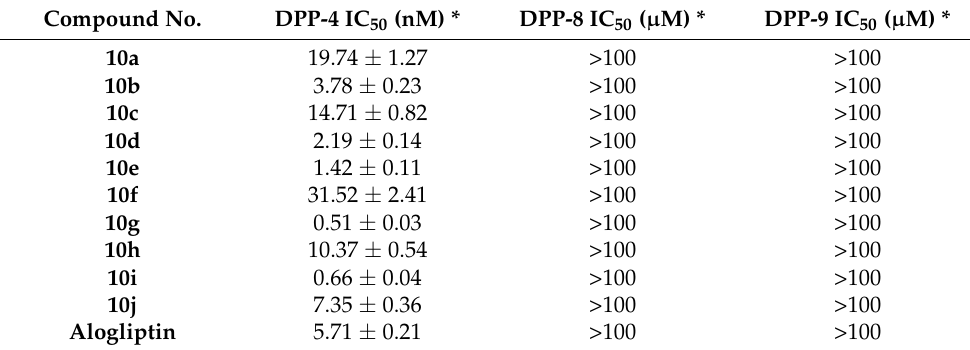
Table 1. DPP-4, DPP-8 and DPP-9 inhibitory activities of hybrids 10a–j and alogliptin. Compound